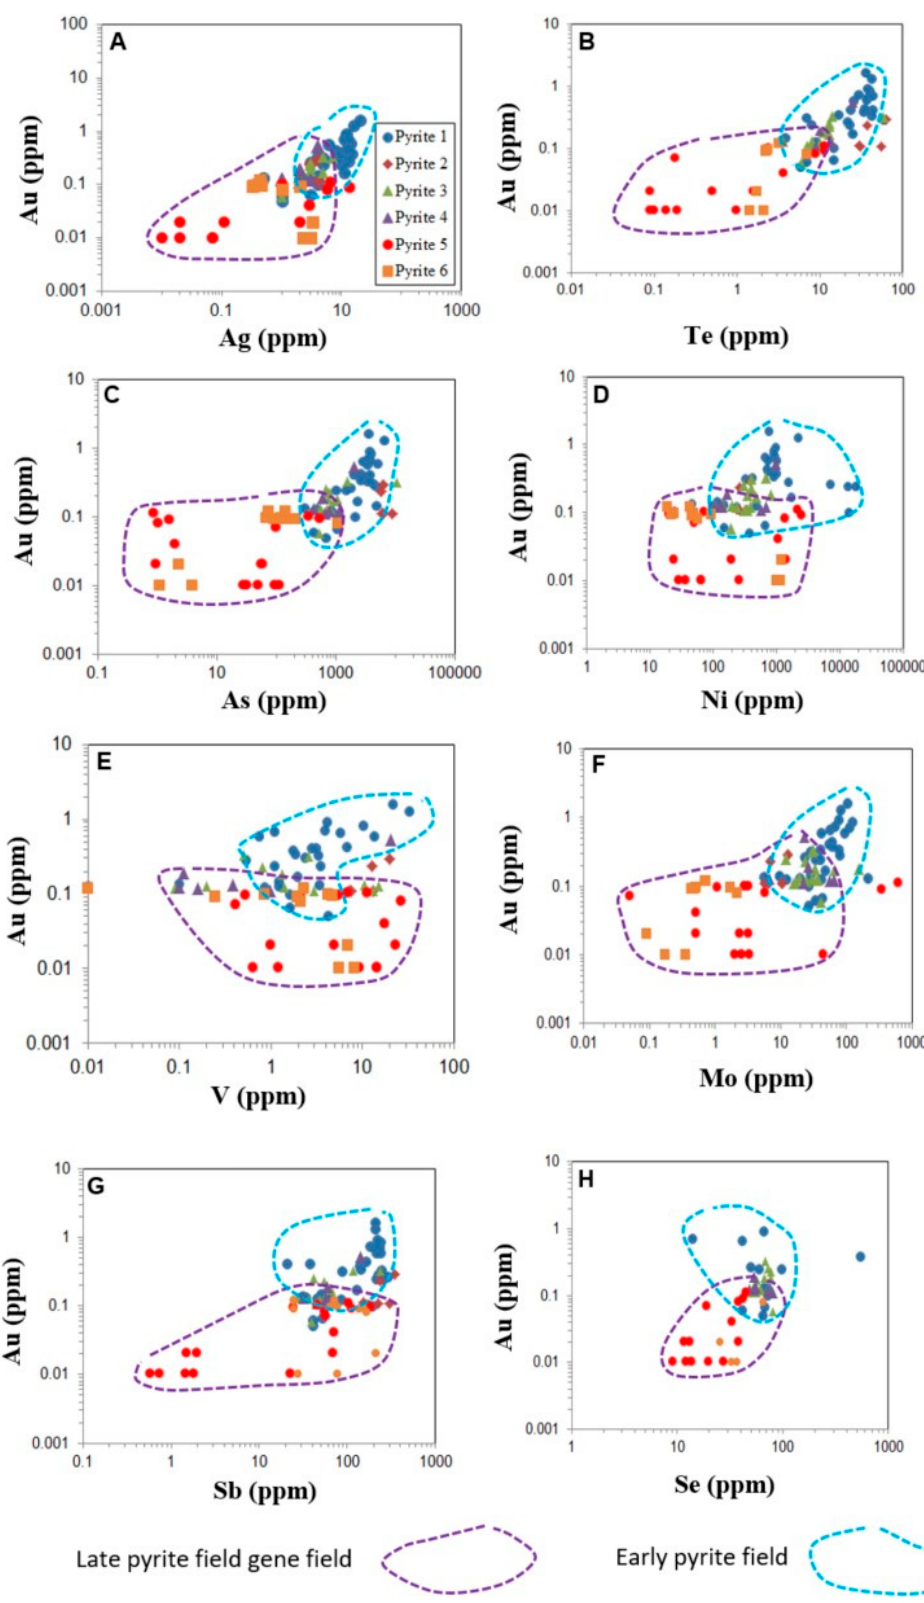
Figure 8. Scatter plot of Au versus other trace elements in pyrite from the Singa Formation, Malaysia.